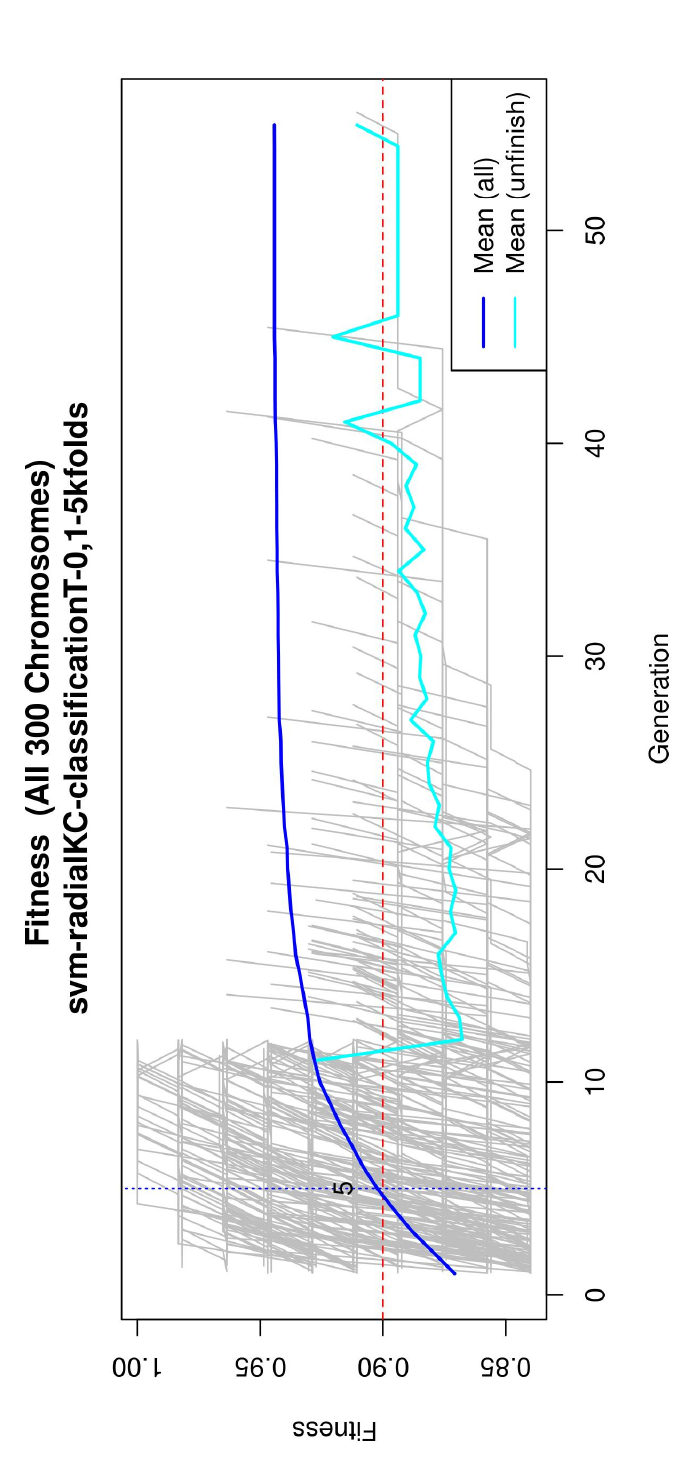
Figure A2. Evolution of the maximum fitness score across generations. The horizontal axis represents a given generation, whilst the vertical axis represents the fitness score. The average fitness, plotted with a blue solid line, considers all models. The average unfinished fitness, plotted with a cyan solid line, considers all searches that failed for a given generation and represents the average worst-case expectation. The established GA goal fitness is plotted with the red dotted